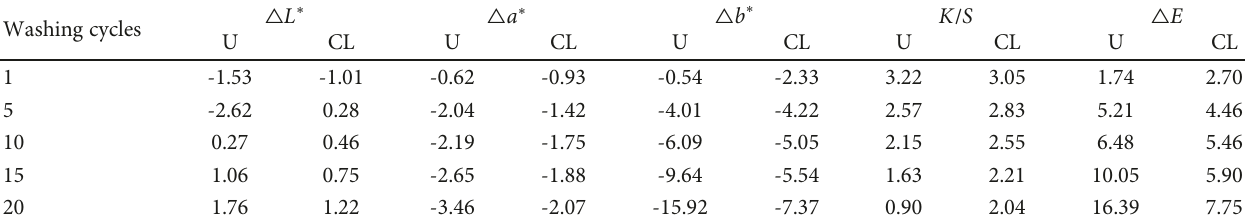
Figure 4: SEM observation of uncross-linked and cross-linked NCS fi lament before and after degumming ((a) and (b): uncross-linked fi ber before and after degumming; (c) and (d): cross-linked fi ber before and after degumming). Table 1: E ff ects of repeated washing on the color of cross-linked and uncross-lined NCS